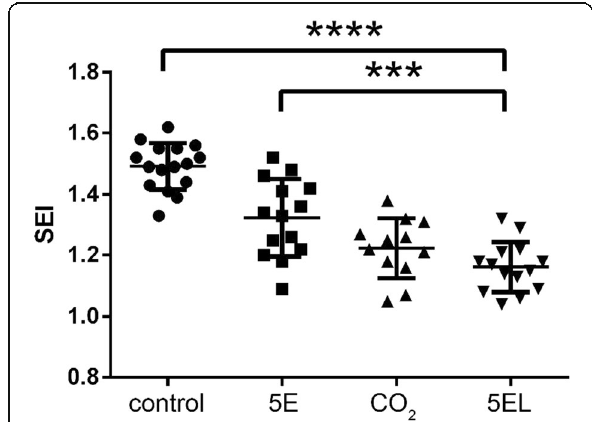
Fig. 8 Comparison of SEI of rabbit hypertrophic scars after applied different treatments for 7 days. 5EL: the enthosomal gels encapsulated with 5-FU combined with CO 2 fractional laser, n =14; CO 2 : CO 2 fractional laser, n =12; 5E: the enthosomal gels encapsulated with 5-FU, n =14; control: blank, n = 16. *** p value < 0.001 was considered statistically extremely significant and **** p value < 0.0001 was